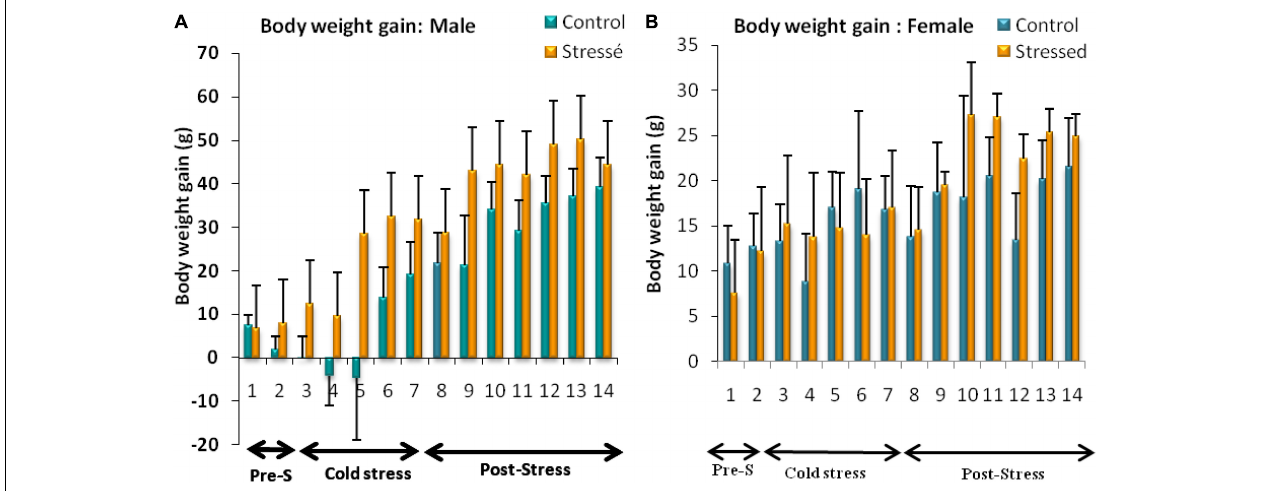
FIGURE 3 | Body weight changes observed in control and stressed rats of both sexes. Cold stress increases body weight gain in male rats (A) but does not affect female’s body weight (B) . Weight gain is expressed in grams. Data are represented as mean ± SEM ( n = 5). (A) Male rats: Effect of stress: *** p < 0.001; Effect of the day: **** p < 0.0001; Bonfferoni’s post hoc test showed no significant interaction between stress and day on body weight gain ( p = 0.9393). (B) Female rats: Effect of stress: ns p > 0.05; Effect of the day: ns p > 0.05 (ns: not